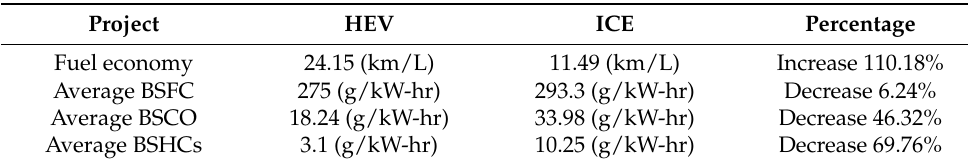
Table 1. Datasheet of HEV experimental